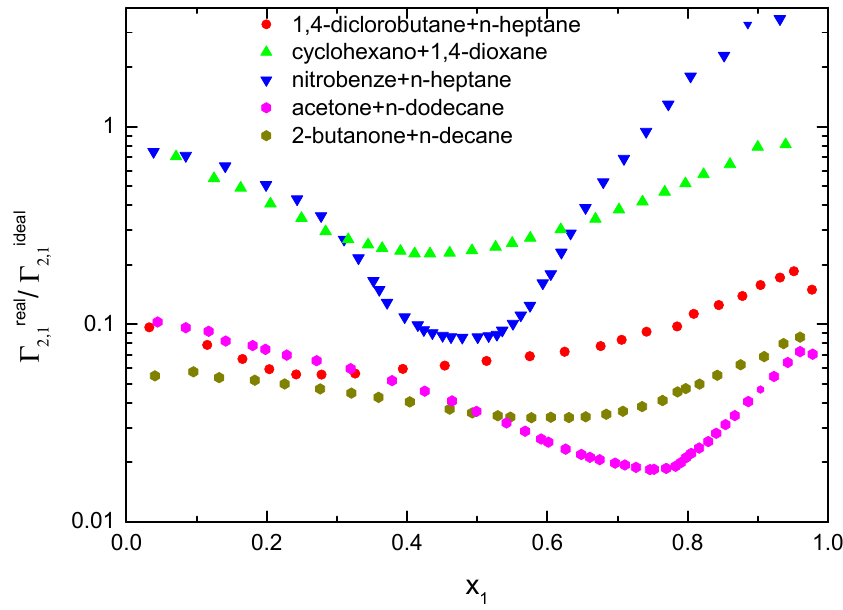
Figure 3. Ratio of the relative surface concentration, Γ 2,1 , for real and ideal mixtures.